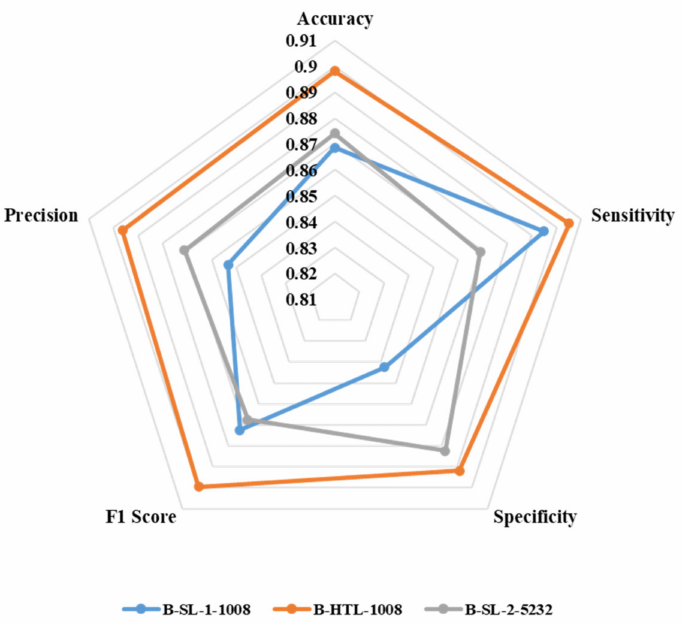
Figure 7. The radar chart for illustrating the accuracy, sensitivity, specificity, F1 score and precision of B-SL-1-1008, B-HTL-1008 and